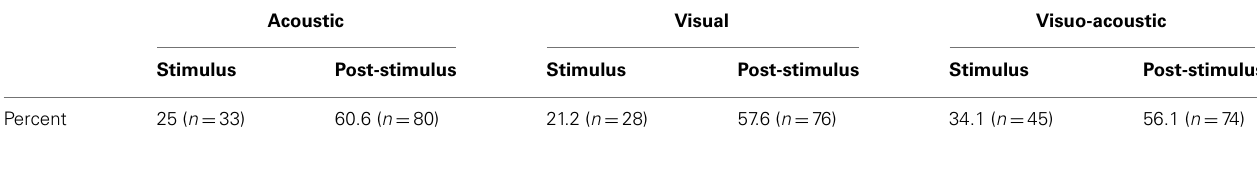
Table 2 | Proportion of neurons exhibiting a change in their activity as a function of the sensory modality and the